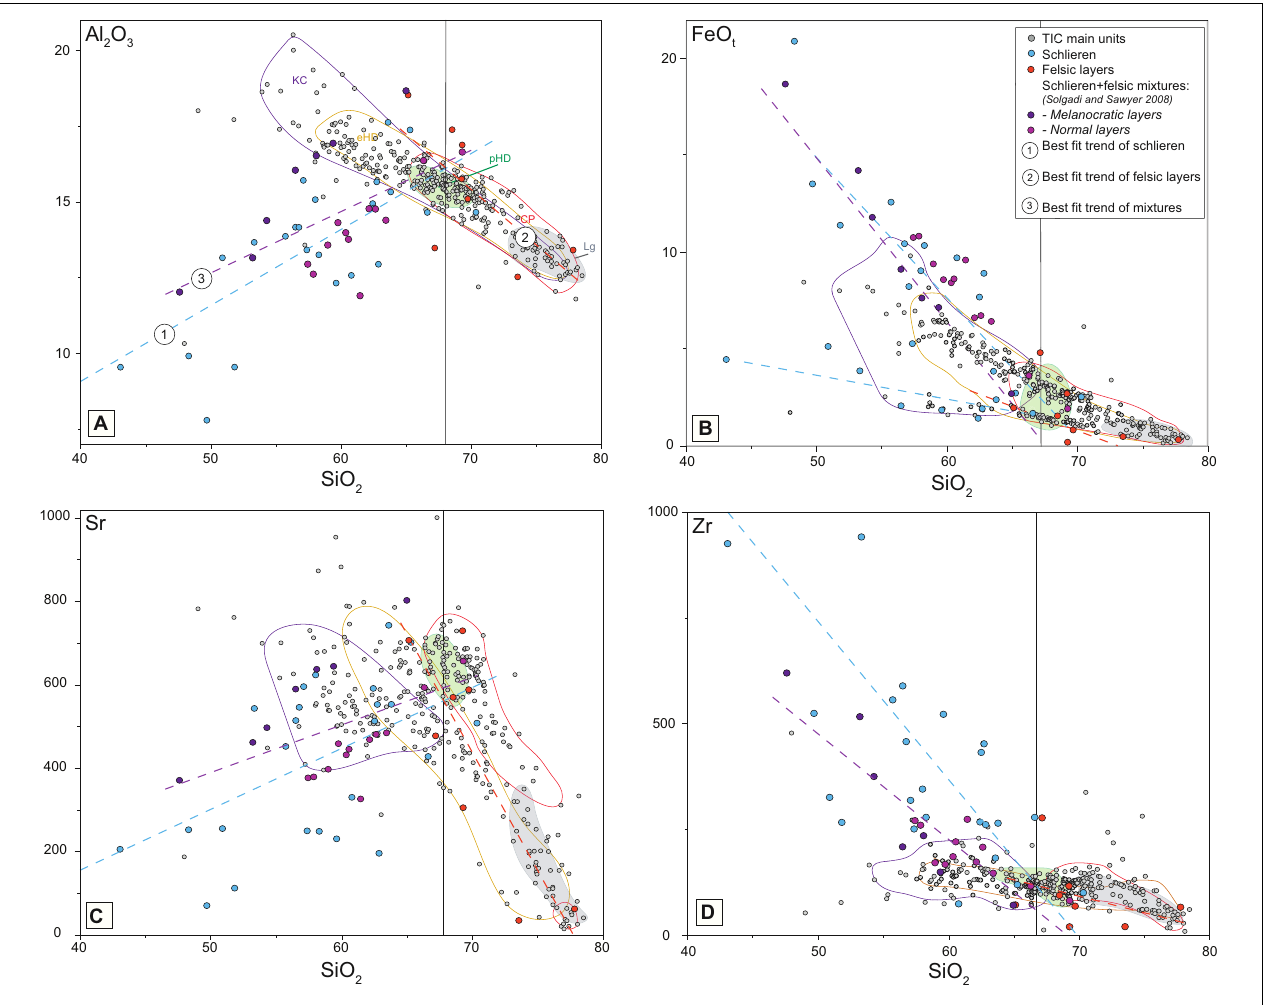
FIGURE 10 | Major and trace element data from schlieren, felsic components, and host TIC samples. (A) Al 2 O 3 v. SiO 2 ; (B) FeO t v. SiO 2 ; (C) Sr v. SiO 2 ; (D) Zr v. SiO 2 . Data sources: Bateman and Chappell (1979), Peck and Van Kooten (1983), Kistler et al. (1986), Bateman et al. (1988), Loetterle (2004), Burgess and Miller (2008), Gray et al. (2008), Paterson et al. (2008), Solgadi and Sawyer (2008), Economos et al. (2009), Memeti (2009), Žák et al. (2009), Coleman et al. (2012), and new data ( Table 2